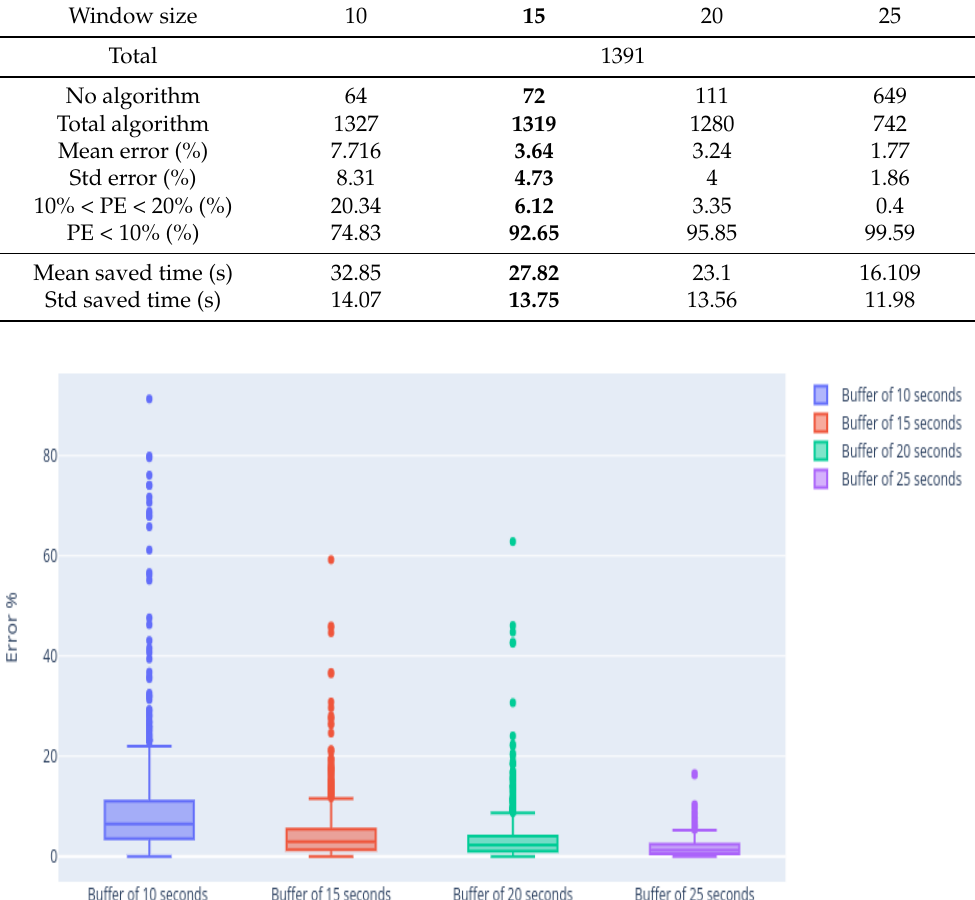
Figure 16. The box-plots of the error between the last real intensity of the amperogram and the estimated